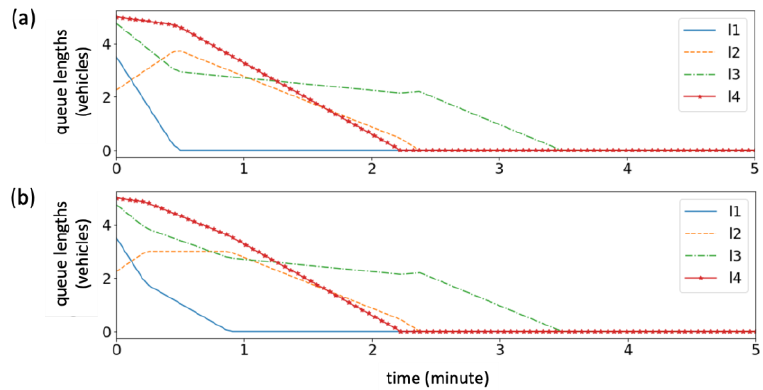
Figure 5. ( a ) Optimal merge-in flows; ( b ) queue lengths; ( c ) segment flows.